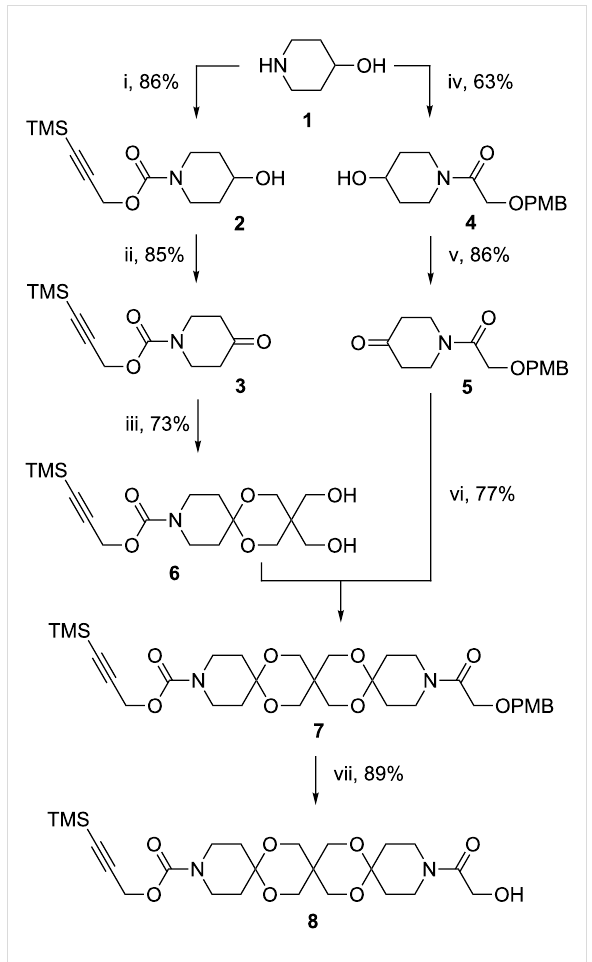
Scheme 1: Synthesis of building block 8 (i: trimethylsilylpropargyl-4- nitrophenylcarbonate. ii: Dess–Martin-periodinane. iii: